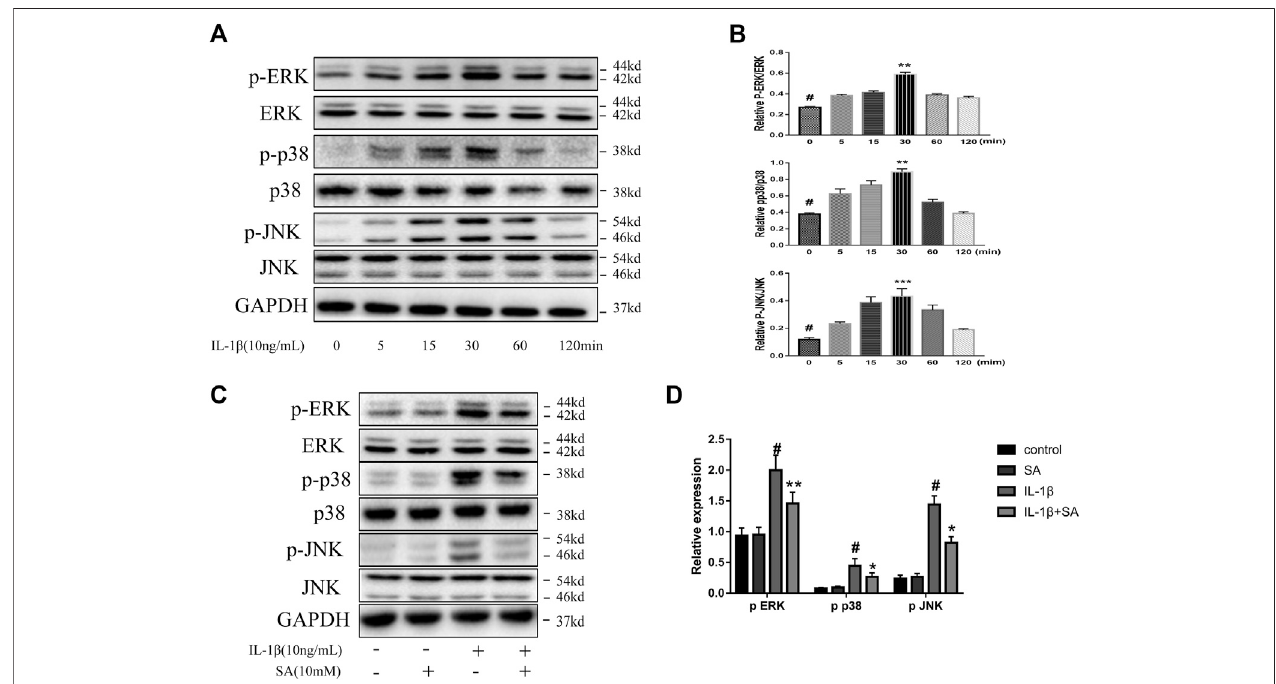
FIGURE5| SArestrainIL-1 β -inducedactivationoftheMAPKsignalingpathway. (A,B) Representativewesternblotsandquanti fi cationdatashowingp-ERK,ERK, p-p38,p38, p -JNKandJNKexpressionincellstreatedwithIL-1 β fordifferenttimepoints.Thedataareshownasthemean ± SD.*** p < 0.001,** p < 0.01vs # thecontrol group ( n (cid:2) 3). (C,D) Representative western blots and quanti fi cation data showing p -ERK, ERK, p-p38, p38, p -JNK, and JNK expression in cells after 30 min of IL-1 β exposure. The data are shown as the mean ± SD ( n (cid:2) 3). # p < 0.05 vs. the control group; ** p < 0.01, * p < 0.05vs. the IL-1 β